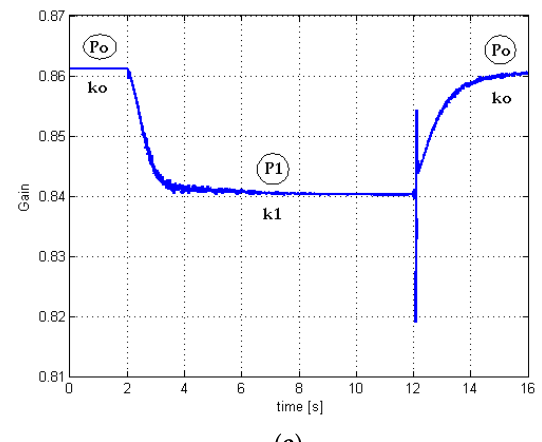
Figure 3. ( a ) Mechanical torque variation; ( b ) controlled output (terminal voltage); ( c ) controller output (excitation voltage); ( d ) closed-loop process parameters estimates-polynomials 𝐴(cid:4632)(𝑧 (cid:2879)(cid:2869) ) and 𝐵(cid:3552)(𝑧 (cid:2879)(cid:2869) ) (functioning points: P0-> P1-> P0); ( e ) closed-loop process gain estimates 𝑘(cid:3552) (cid:3034)(cid:3028)(cid:3036)(cid:3041) =